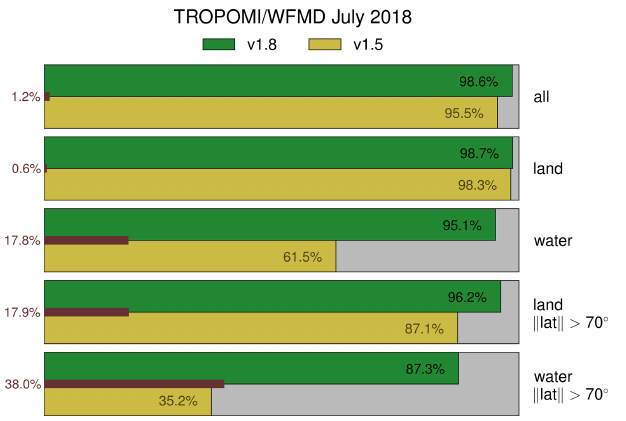
Figure 8. Percentage of actually cloud-free scenes according to VIIRS among all scenes passing the quality filter for July 2018 shown in green and yellow for v1.8 and v1.5, respectively. The corresponding relative data loss of good measurements passing the quality filter due to the more stringent filtering in v1.8 compared to v1.5 is highlighted by the red